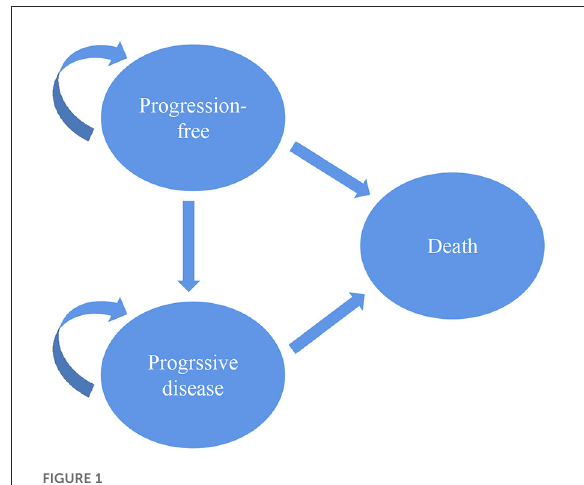
FIGURE1 Three-state Markov